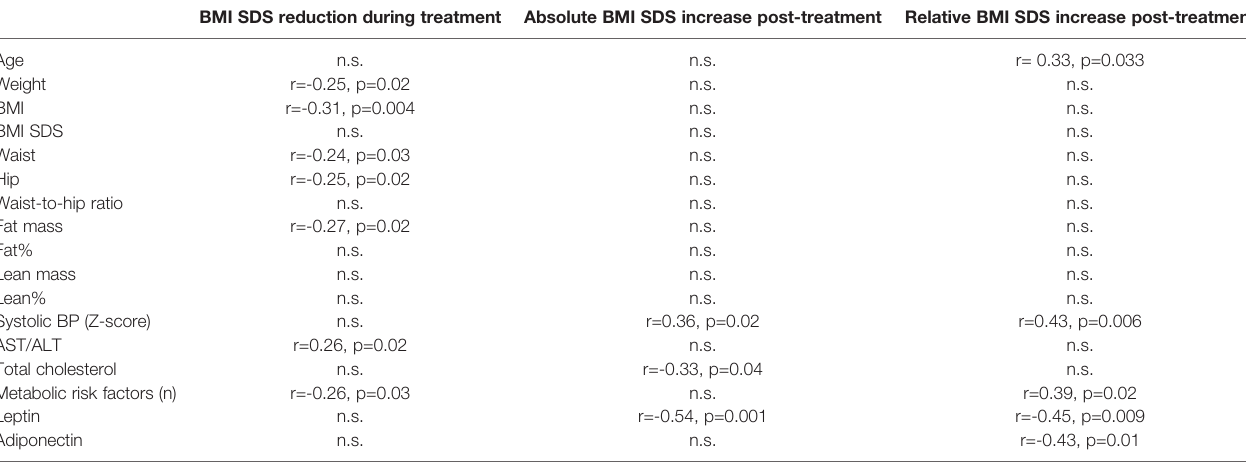
TABLE 3 | Partial correlations from univariate linear regressions between baseline variables and treatment